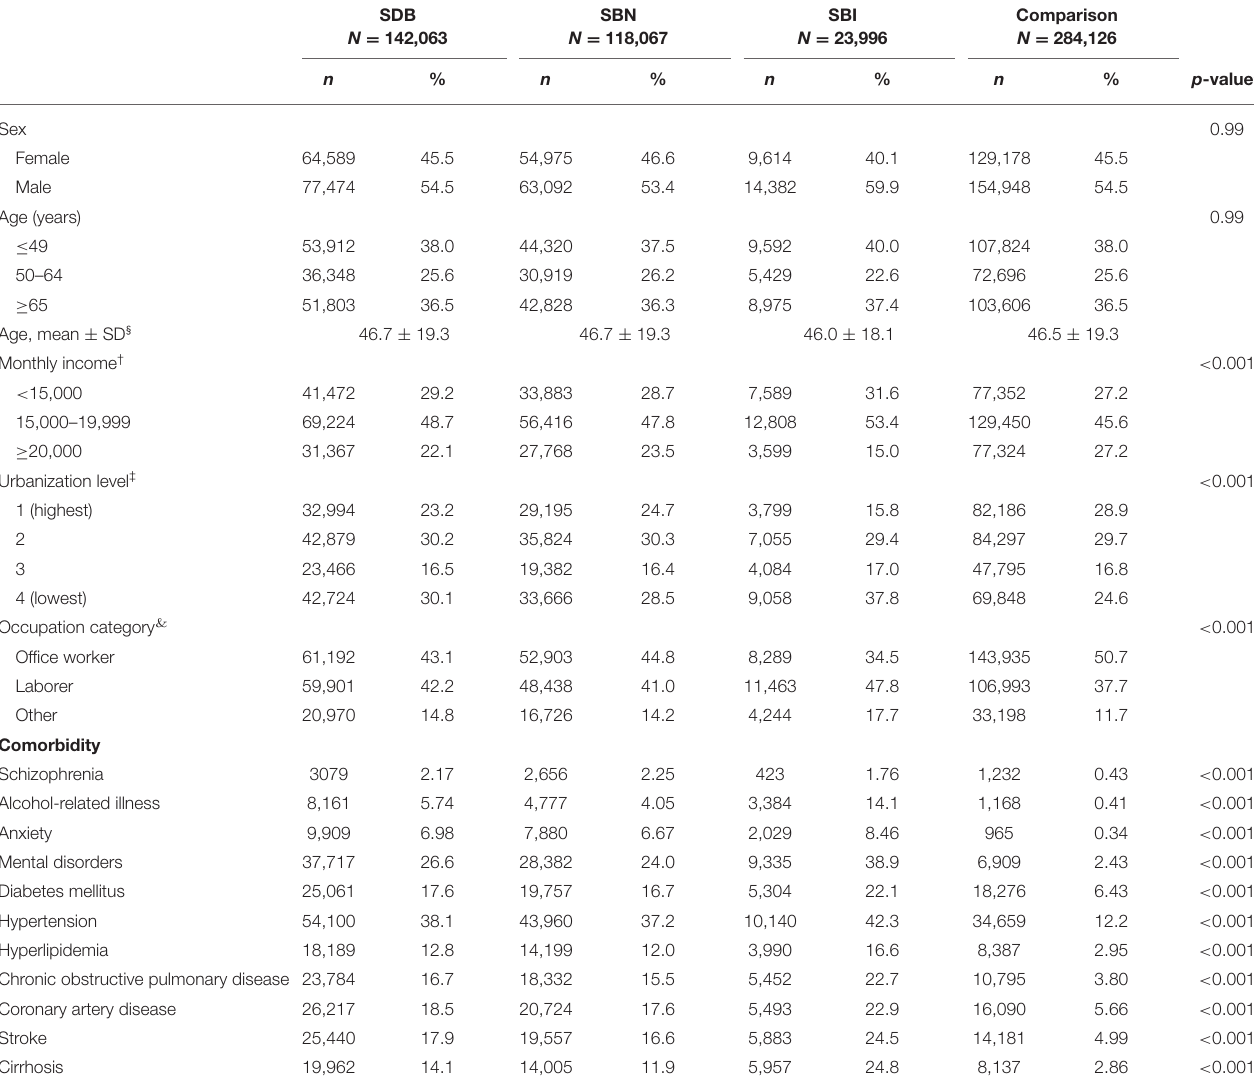
TABLE 1 | Distribution of sex, age, monthly income, urbanization level, occupation, and comorbidities between the SDB, SBN, SBI, and comparison